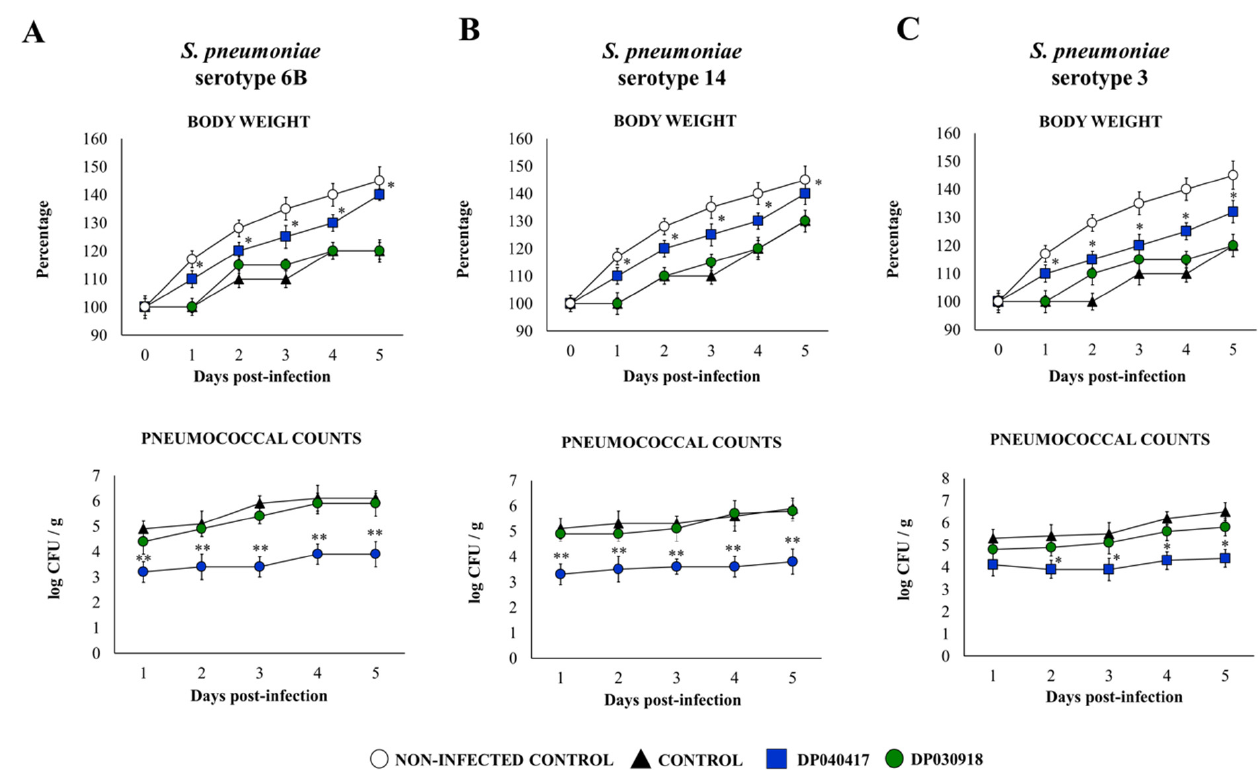
Figure 1. Effect of the respiratory commensal bacteria Dolosigranulum pigrum on resistance to Streptococcus pneumoniae infection. Infant mice were nasally primed with viable D. pigrum (DP) strain 040417 or 030918 during five consecutive days at a dose of 10 8 bacterial cells/mouse/day. One day after the last administration of DP strains, mice were challenged with ( A ) S. pneumoniae serotypes 6B ( A ), 14 ( B ), or 3 ( C ). Non-treated infant mice challenged with the corresponding serotypes of S. pneumoniae were used as controls. Changes in body weight and lung pneumococcal cell counts were evaluated on different time points after the bacterial challenge. The results represent data from three independent experiments ( n = 6 per each group at each time point). Significantly different when compared with control at the same time point, * p < 0.05 or ** p < 0.01.